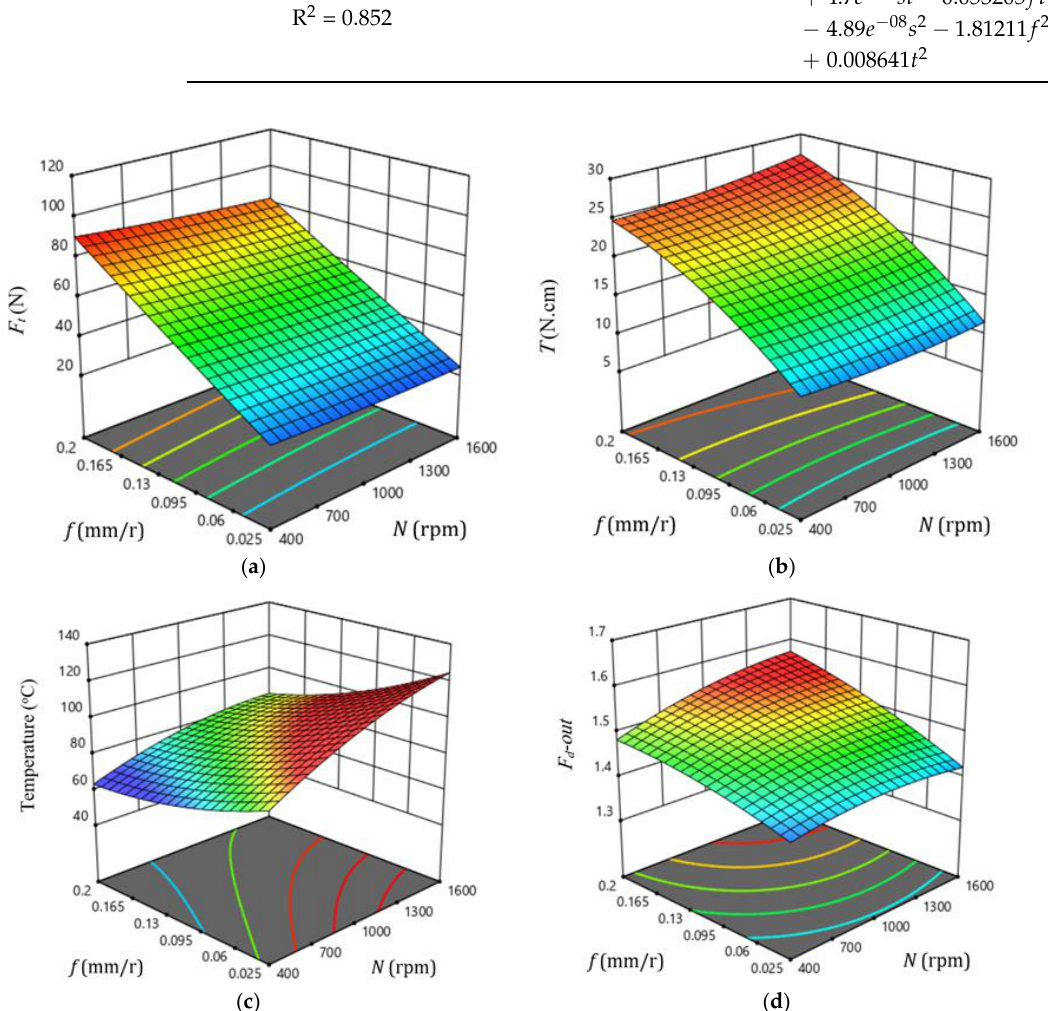
Figure 16. Response surface plots showing the effect of drilling parameters on the machinability properties of GFRP composite with a thickness of 7.7 mm: ( a ) F t , ( b ) T , ( c ) temperature, and ( d ) F d - out.